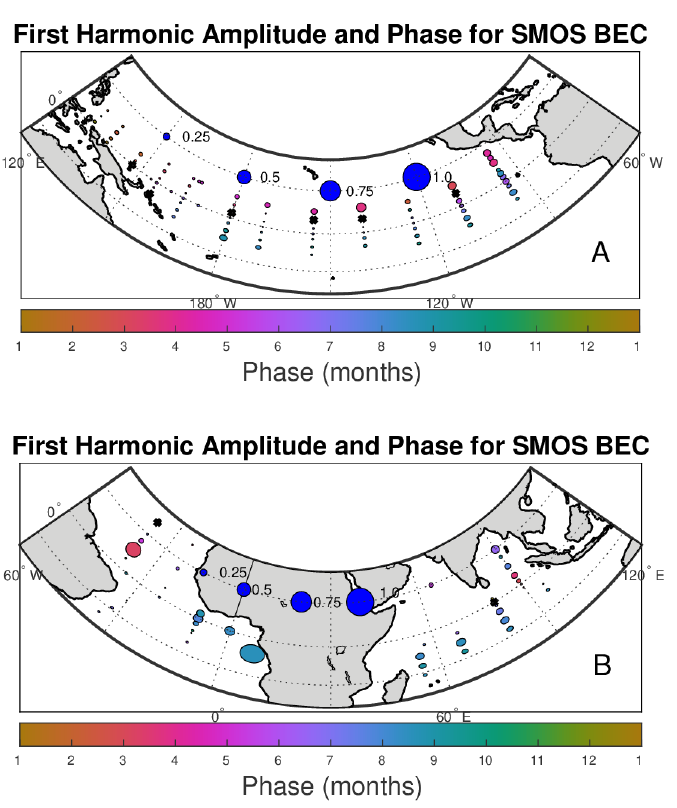
Figure 6. As in Figure 3, but for the SMOS BEC data. (a) Pacific basin. (b) Atlantic and Indian ba-